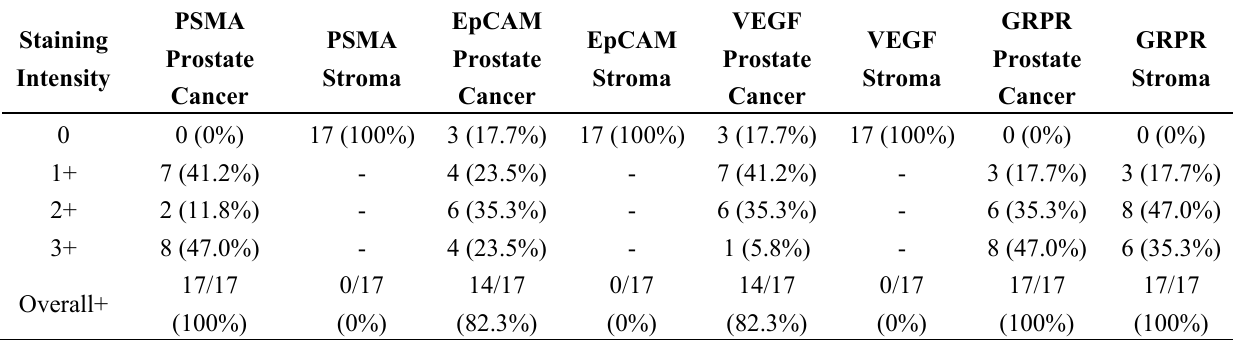
Table 2. Immunohistochemical staining intensity of prostate cancer and